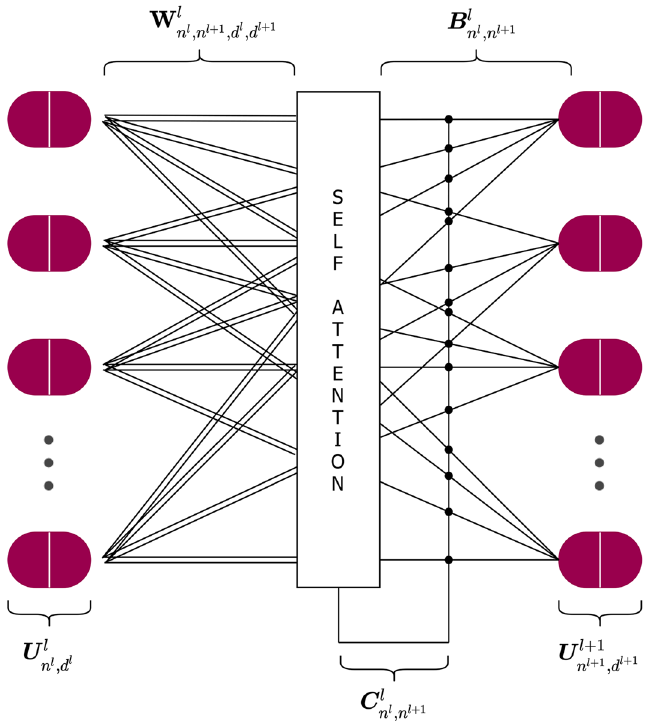
Figure 4. Capsules of the layer l -th make predictions of the whole they could be part of. All predictions obtained with the weight tensor W conjunction with the priors B l + 1